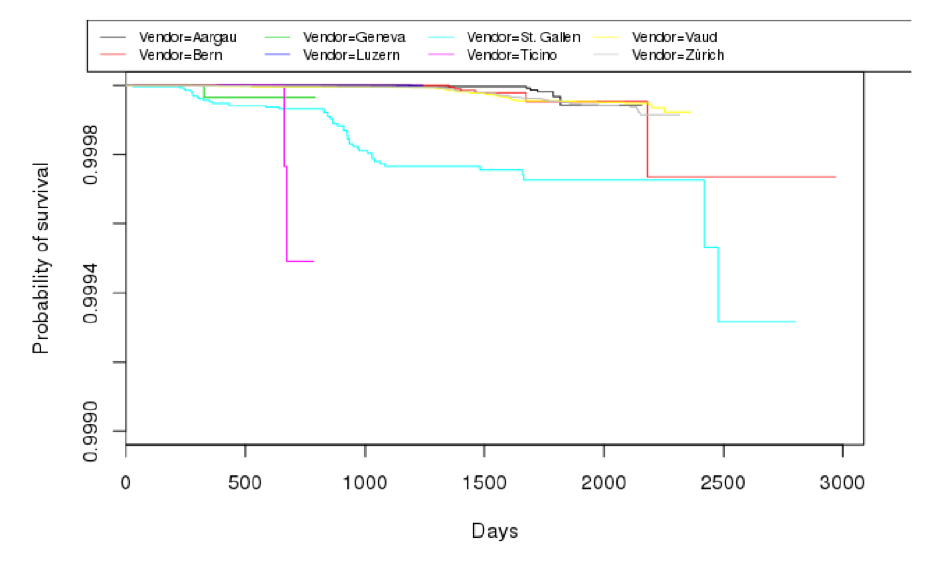
Figure 4. Disk survival rate by vendor corrected for data center